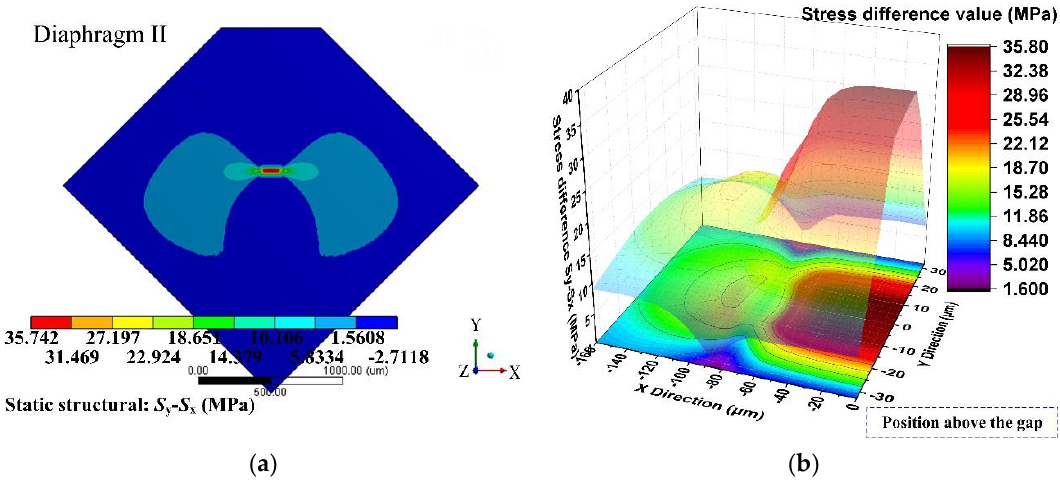
Figure 15. Stress difference ( σ = S y − S x ) distribution of diaphragm II: ( a ) stress difference ( σ = S y − S x ) distribution of a 1/4 model; ( b ) detailed stress difference ( σ = S y − S x ) distribution of 1/2 SCR.